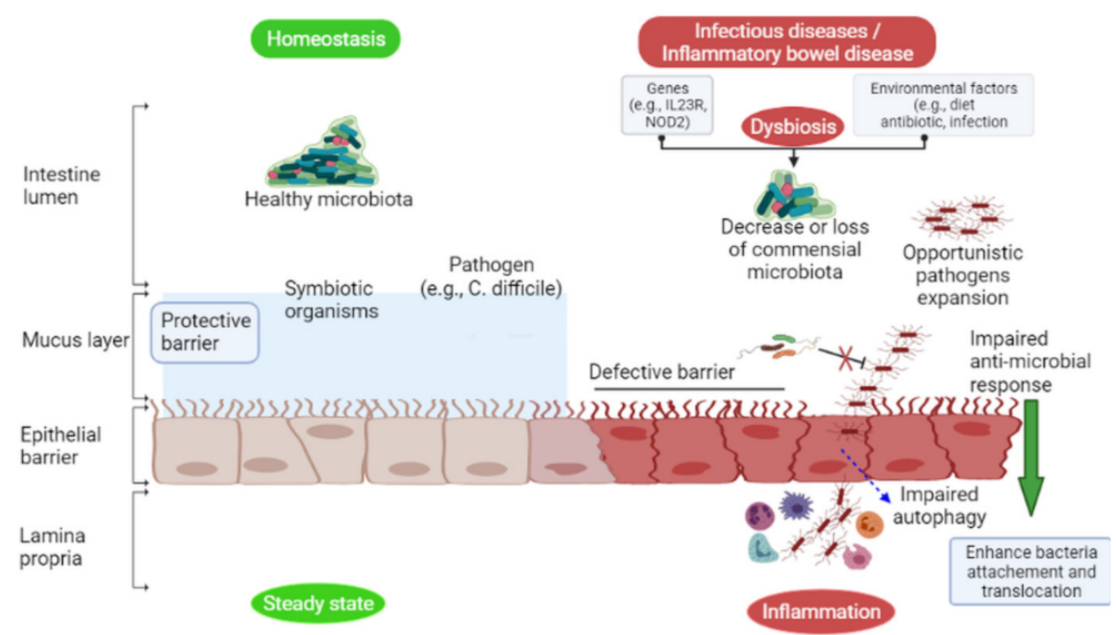
Figure 1. Under homeostatic conditions ( left green), certain Gram-negative commensal bacteria induce IgA and IgG antibody production from B cells, recognizing Gram-negative bacteria surface antigens (flagellin, LPS) in the intestinal lumen, thus contributing to host defense against symbionts and pathogens. Symbiotic organisms stimulate mucus production to prevent enteric pathogens from colonizing the intestinal mucosa. However, during dysbiosis ( right red), a decrease or loss of commensal bacteria in the intestine may result in opportunistic pathogens (e.g., C. difficile ) infection due to the secretion of virulence factors (toxins) that damage and breach the epithelial layer, causing